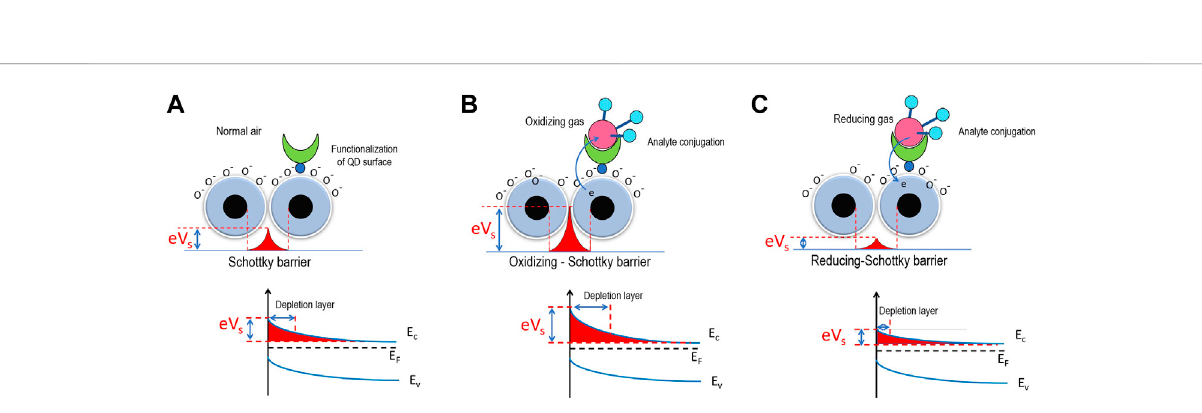
FIGURE 2 Schematic mechanism of gas detection which changes the space charge layer or Schottky barrier. (A) Normal air, (B) oxidizing gas ( λ j , j +1 reducing), and (C) reducing gas ( λ j , j +1